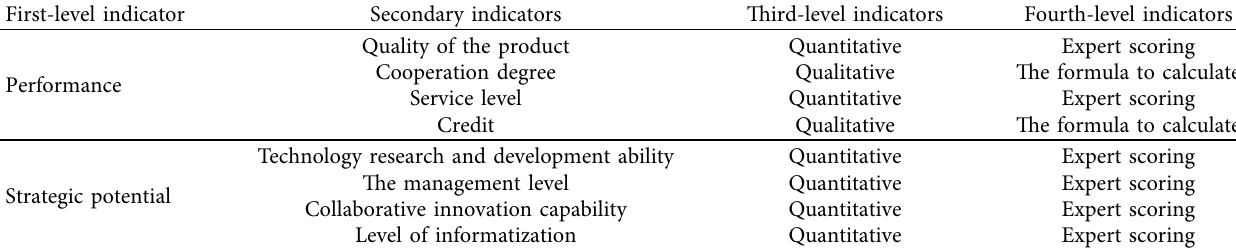
Table 1: Indicators of supplier